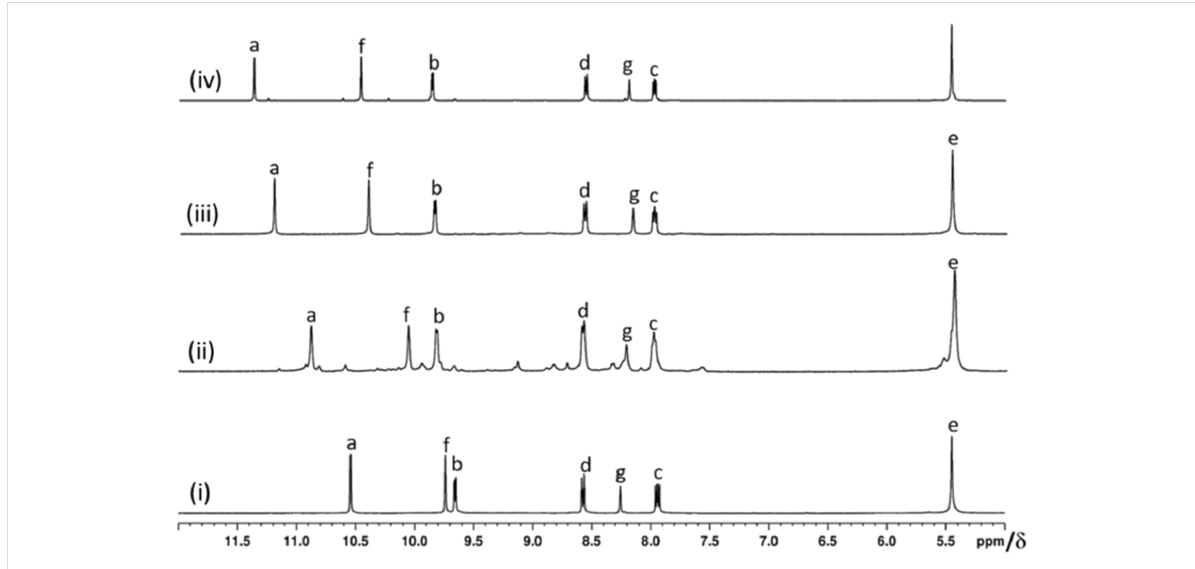
Figure 5: Partial 1 H NMR spectra at 400 MHz in DMSO- d 6 for (i) [(NO 3 ) 2 @Pd 3 ( L1 ) 4 ](NO 3 ) 4 ( 4a ), (ii) [(F) 2 @Pd 3 ( L1 ) 4 ](NO 3 ) 4 ( 5a ), (iii) [(Cl) 2 @Pd 3 ( L1 ) 4 ](NO 3 ) 4 ( 6a ) and (iv) [(Br) 2 @Pd 3 ( L1 ) 4 ](NO 3 ) 4 ( 7a